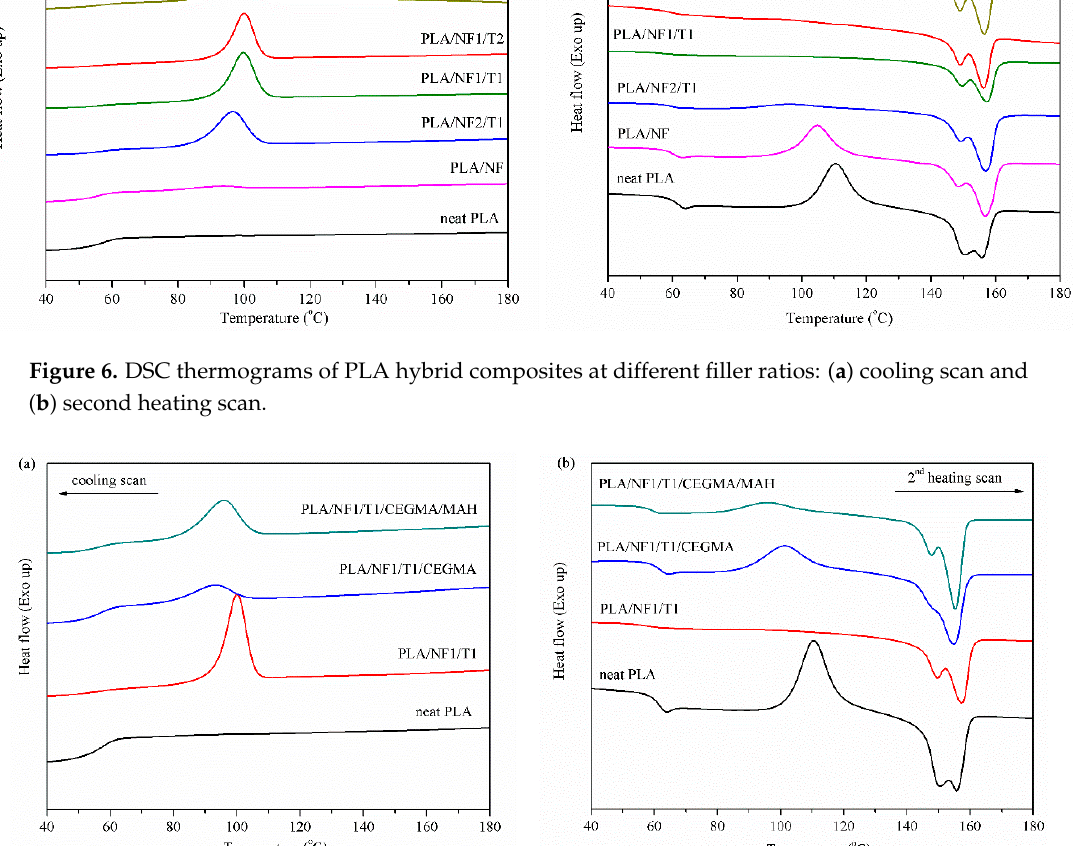
Figure 8. Degree of crystallinity ( X c ) of PLA hybrid composites at different filler ratios, with and without various reactive compatibilizers.